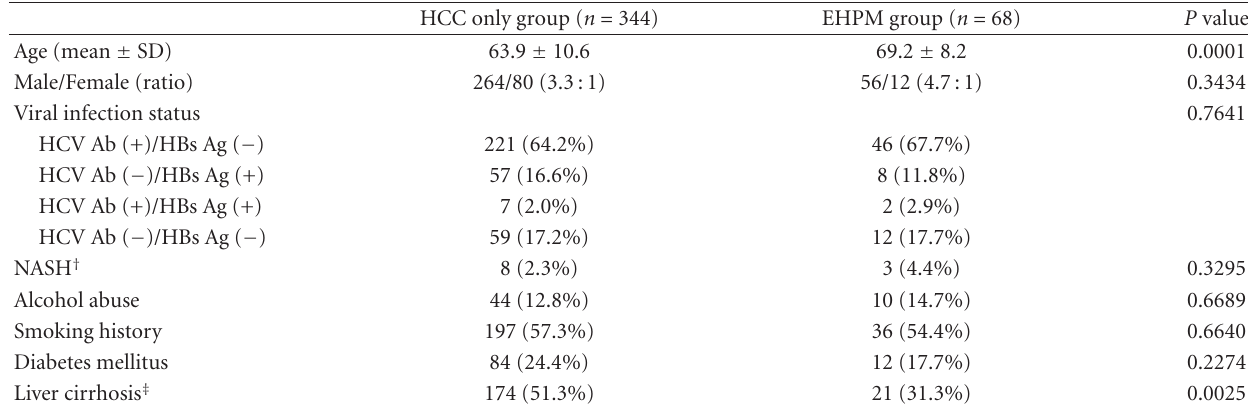
Table 1: Clinical characteristics of HCC-only and EHPM